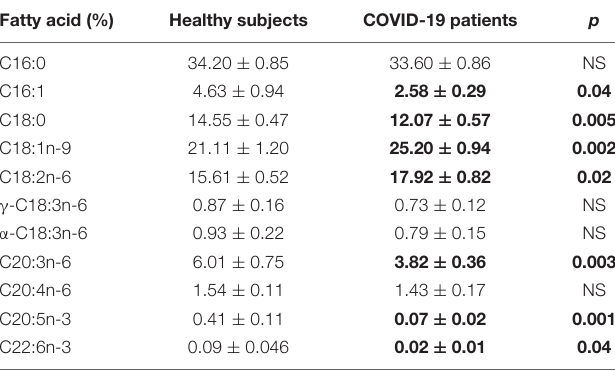
TABLE 9 | Fatty acid compositions of the NEFAs in the plasma from the healthy subjects and COVID-19 patients. Healthy subjects